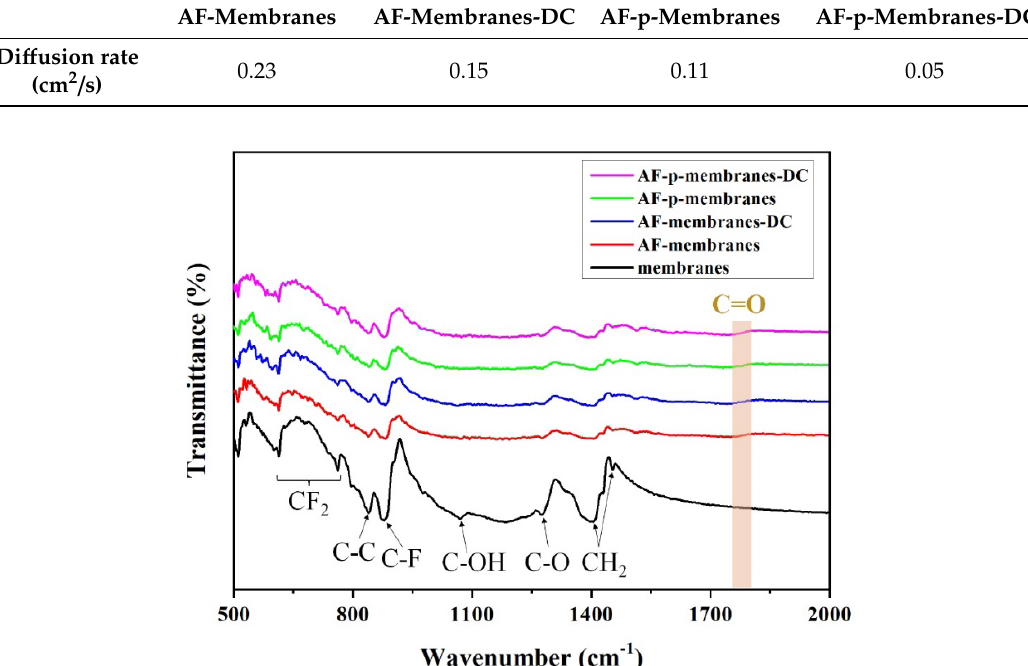
Figure 7. Diffusion rate of a water droplet on the PVDF/CFO membranes: ( a ) AF-membranes with Figure 7. Di ff usion rate of a water droplet on the PVDF / CFO membranes: ( a ) AF-membranes with 0.23 cm 2 /s, ( b ) AF-membranes-DC with 0.15 cm 2 /s, ( c ) AF-p-membranes with 0.11 cm 2 /s, and ( d ) AF- 0.23 cm 2 / s, ( b ) AF-membranes-DC with 0.15 cm 2 / s, ( c ) AF-p-membranes with 0.11 cm 2 / s, and ( d ) AF-p- p-membranes-DC with 0.05 cm 2 /s. membranes-DC with 0.05 cm 2 / s. Table 2. Di ff usion rate of a water droplet on the PVDF / CFO membranes. Table 2. Diffusion rate of a water droplet on the PVDF/CFO membranes.